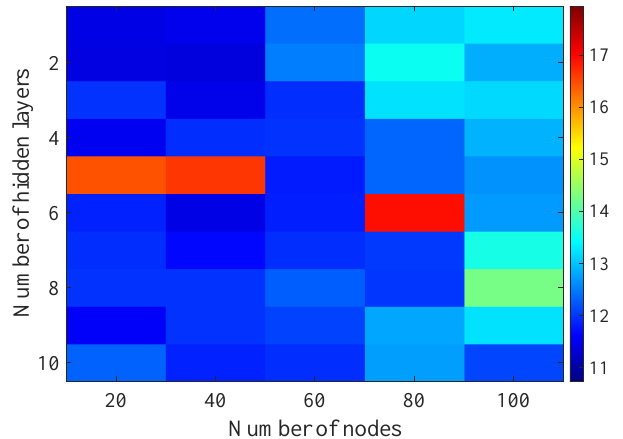
Figure 15. Matrix of the BLER RMSE metric predictions for the radio parameters history window W = 10 in the second stage learning process.